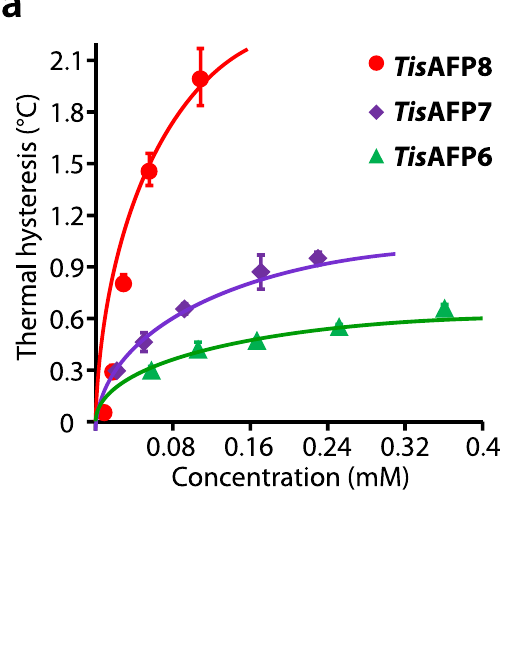
For Tis AFP6, most of the replaced residues (7 residues out of 11) from Tis AFP7 and Tis AFP8 are situated in the capping head regions, which seems to originate the highest T m among the isoforms. scopic images of a cooled ice crystal used for TH measurements. At 0.23 mM Tis AFP7 (TH 0.9 °C), the single ice